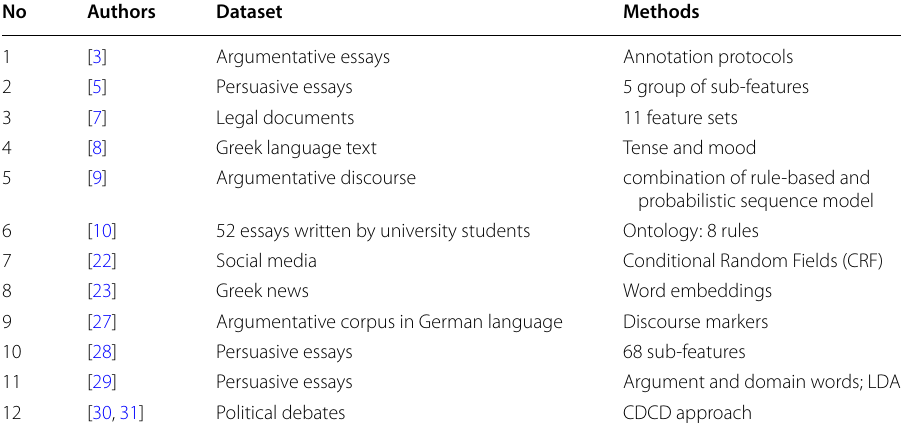
Table 1 Current works in argument